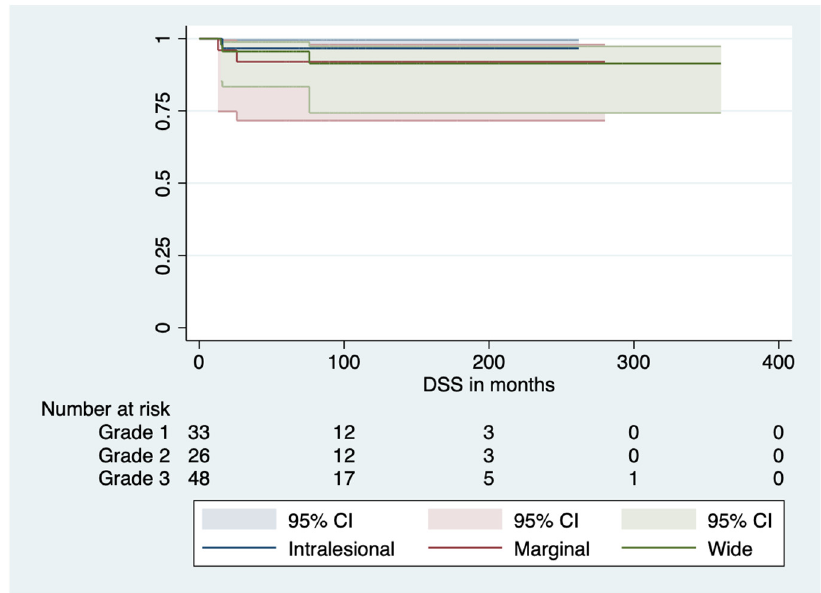
Figure 5. Margin was not signi fi cant in disease speci fi c survival.